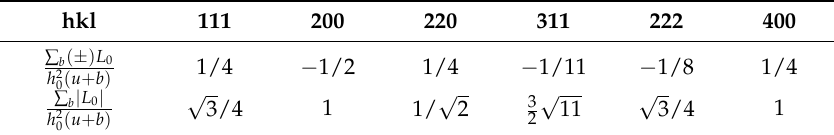
Table 2. Constants for powder pattern of faulted FCC metals